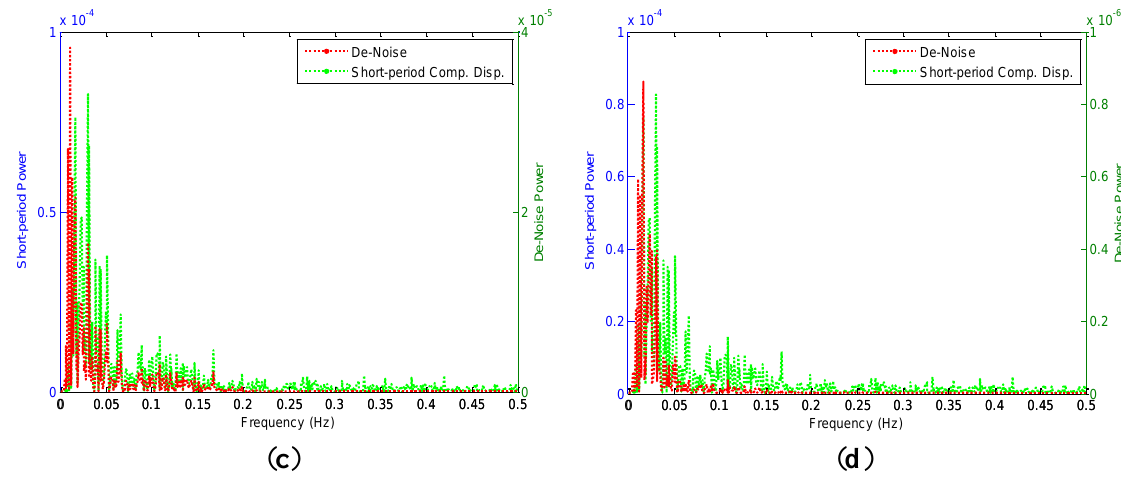
Figure 8. Dynamic performance for z direction. ( a ) Long period displacement; ( b ) Short period displacement; ( c ) Multi filter method (MFM) de-noise frequency contents; ( d ) ADFN de-noise frequency contents.